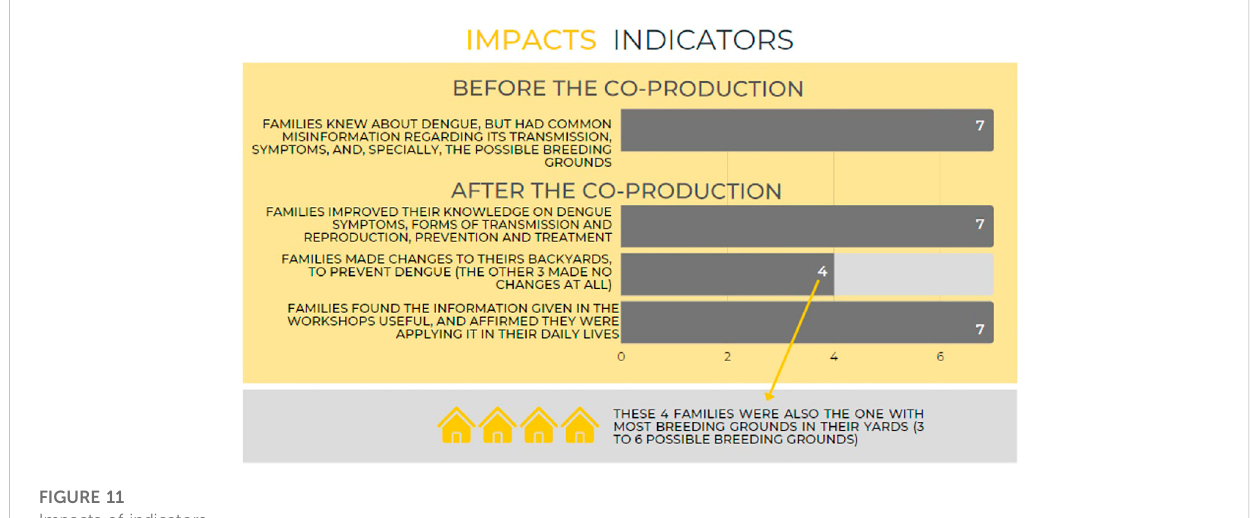
FIGURE 11 Impacts of